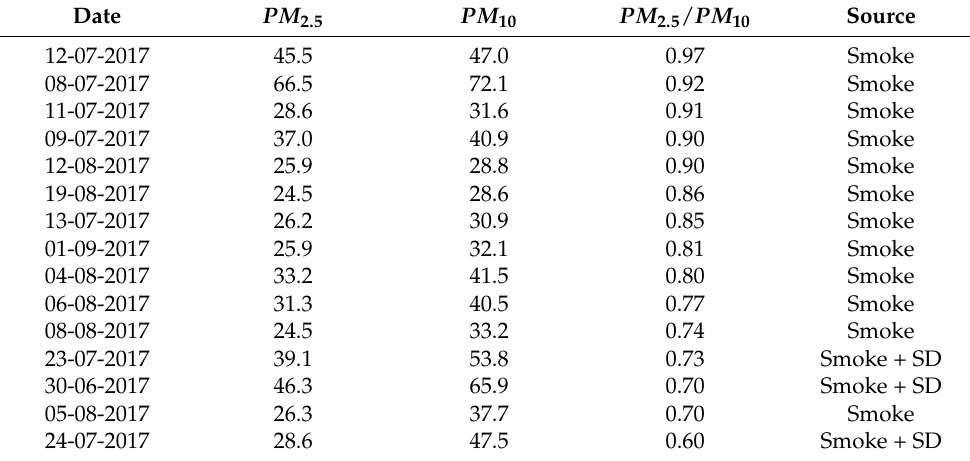
Table 3. Exceedances of PM 2.5 ( µ g m − 3 ) and/or PM 10 ( µ g m − 3 ) with related PM 2.5 / PM 10 ratio and identified source influences. Data are presented with descending order of PM 2.5 / PM 10